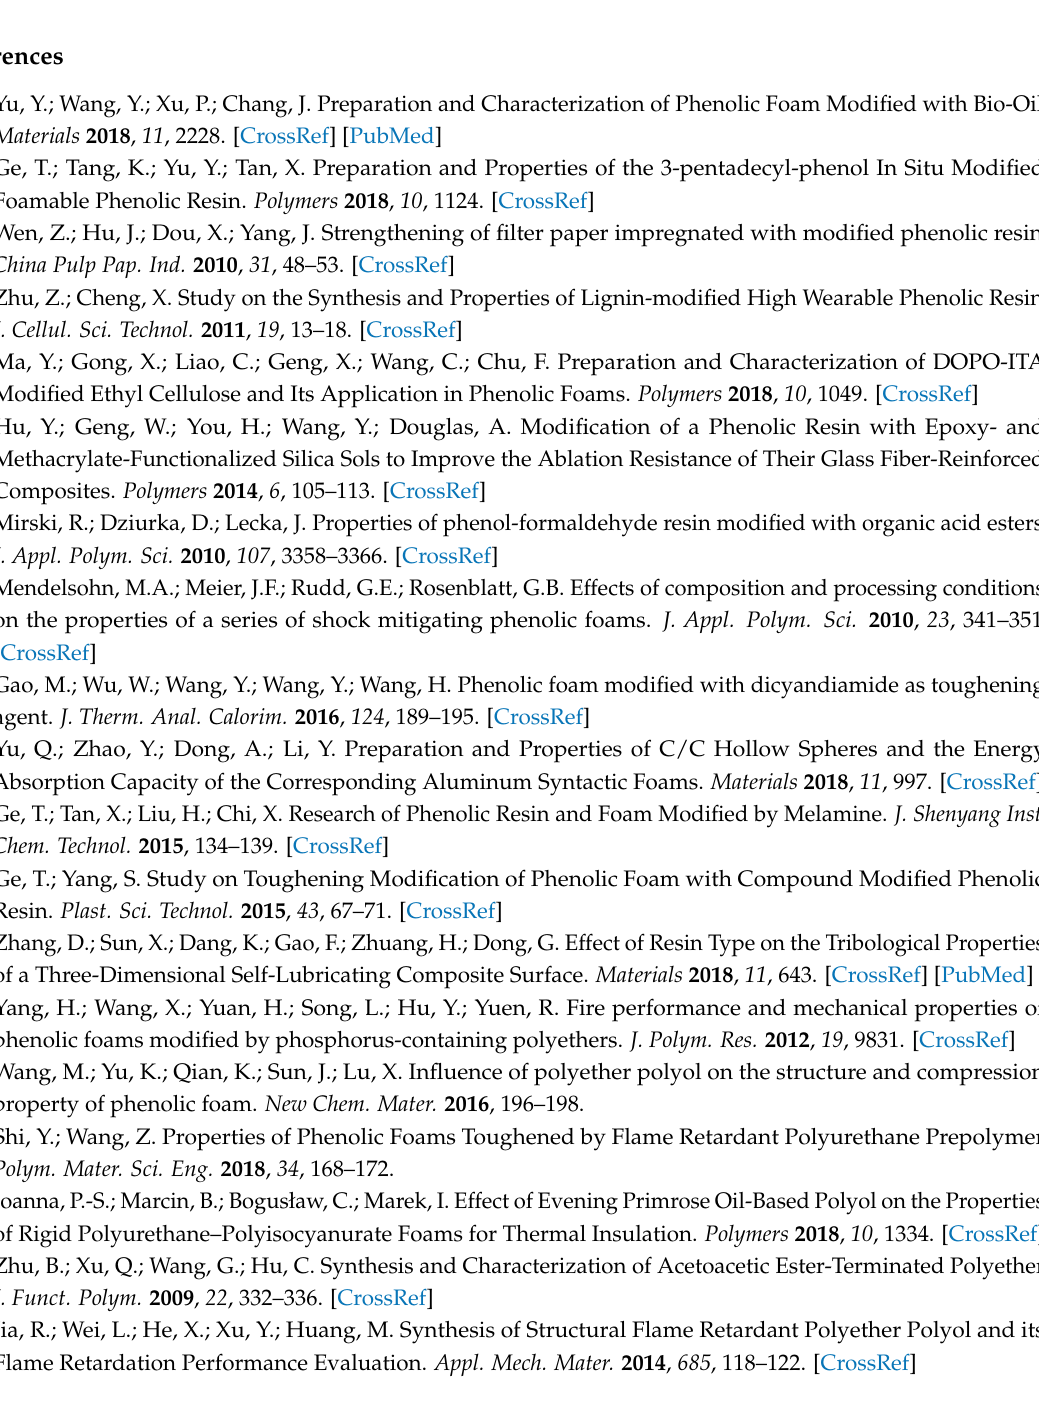
Table S1: The effect of the acetoacetic ester-terminated polyether with different contents on the properties of the